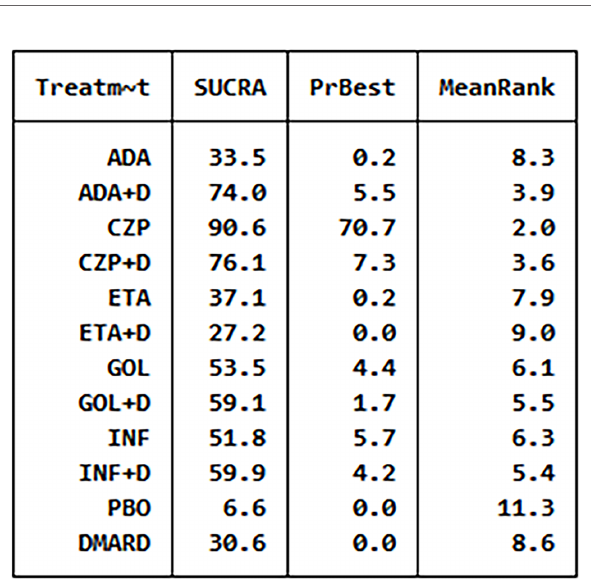
FIGURE 3 | The analysis SUCRA of adverse events for 12 therapies. ADA, adalimumab; + D, plus DMARD; CZP, certolizumab; ETA, etanercept; GOL, golimumab; INF, in fl iximab; PBO, placebo; DMARD, disease-modifying anti- rheumatic